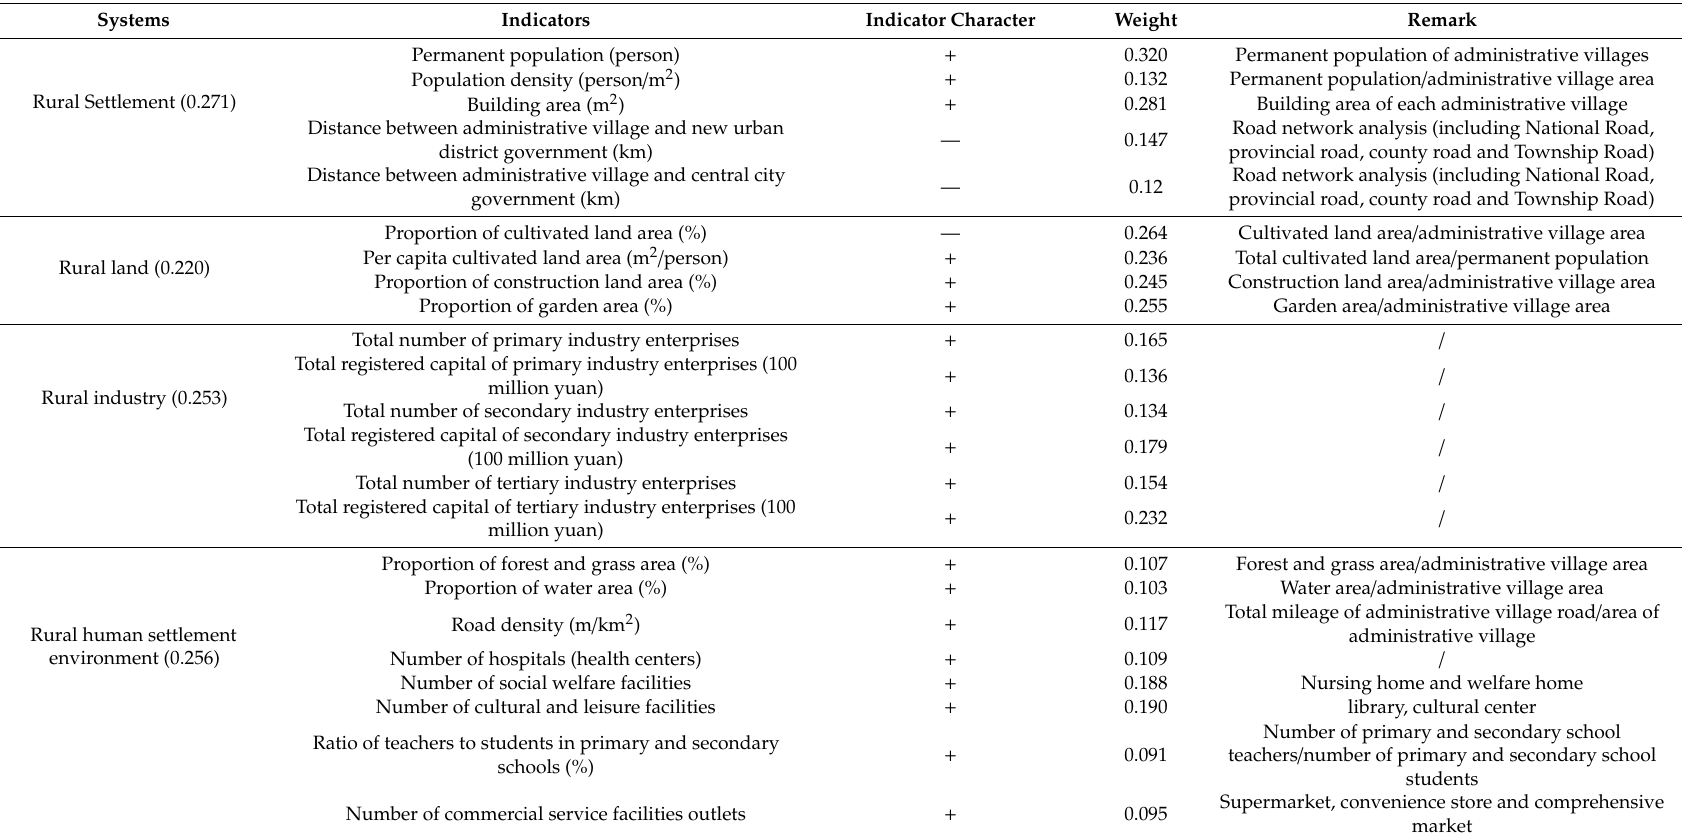
Table 2. Evaluation index system of rural development